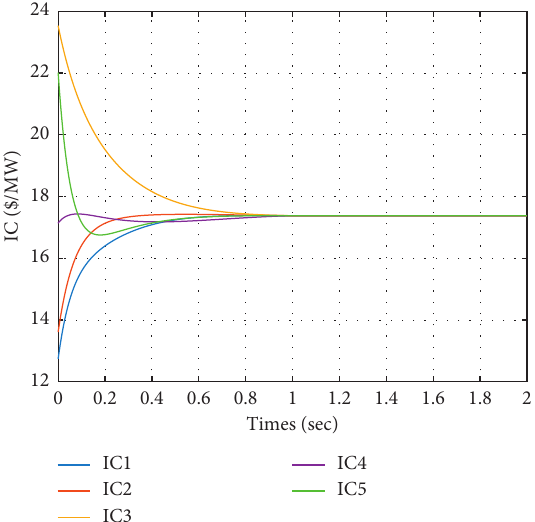
Figure 3: The incremental cost of generator λ